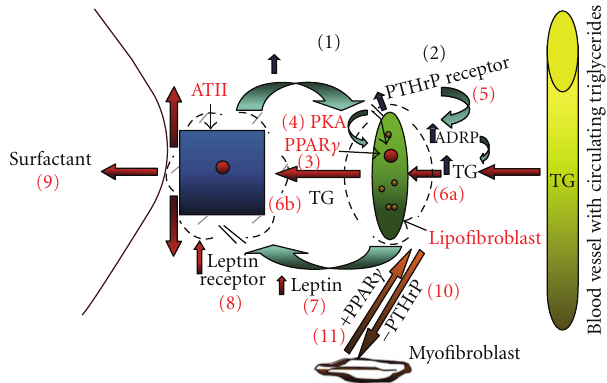
Figure 1: Schematic for paracrine determinants of alveolar home- ostasis and